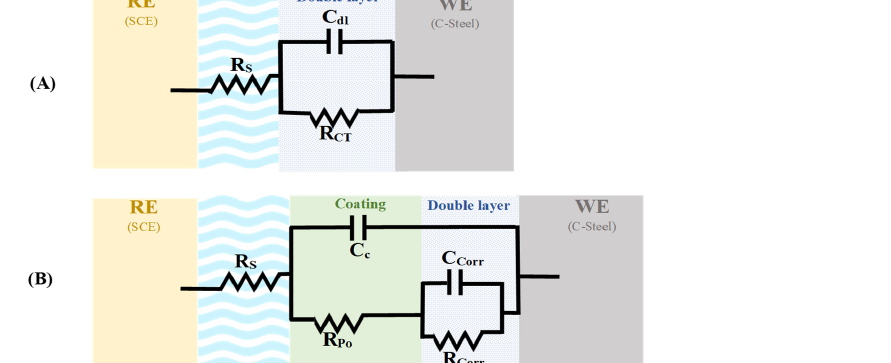
Figure 5. EIS Nyquist plots of ( A ) Bare C-steel, ( B ) PS, ( C ) 1 wt.% PCNs free and impregnated, and ( D ) 3 wt.% PCNs free and impregnated after 1 h of immersion in 3.5 wt.% NaCl at 20 ± 0.5 °C.